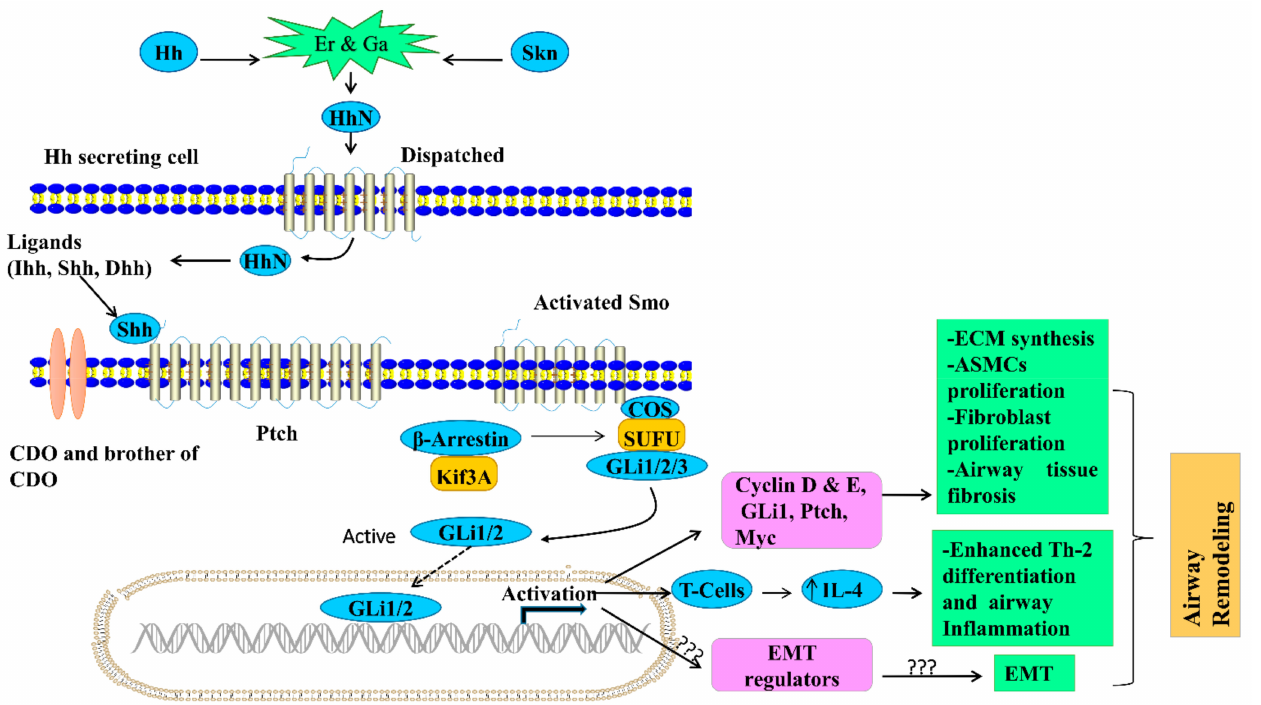
Figure 5. Schematic drawing of overall hypothesis and the mechanism by which Sonic Hedgehog mediates airway remodeling. In the Er or Ga, the Hh or Skn attach to the HhN. The Shh ligand attaches with Ptch through CDO and is ultimately activated the SMO and COS, SUFU, GLI-1/GLI-2 complex through β -arrestin or KIF-3A. Meanwhile, this complex activates the GLI-1/2 and translocates to the nucleus, where it activates and promotes the airway remodeling through three aberrant Hh signaling expressions—ECM synthesis and deposition, ASMC and fibroblast proliferation, and airway tissue fibrosis—which increase Th2 differentiation and inflammation and EMT synthesis. However, the exact role of Shh in airway remodeling via EMT is not yet clear (noted as???). Abbreviations: HhN, Hedgehog N-terminal domain; Skn, skinny hedgehog; COS, Kinesin-like protein costa; SUFU, suppressor of fused; KIF-3A, Kinesin family member-3A; CDO, CAM-related/downregulated by oncogenes; Smo, smooth receptor; ptch, patch receptor; Er and Ga, endoplasmic reticulum and Golgi apparatus; Hh, hedgehog; Shh, Sonic Hedgehog; Ihh, Indian Hedgehog; Dhh, Desert Hedgehog; EMT, epithelial–mesenchymal transition; IL-4, Interleukin-4; Th-2, T helper-2.